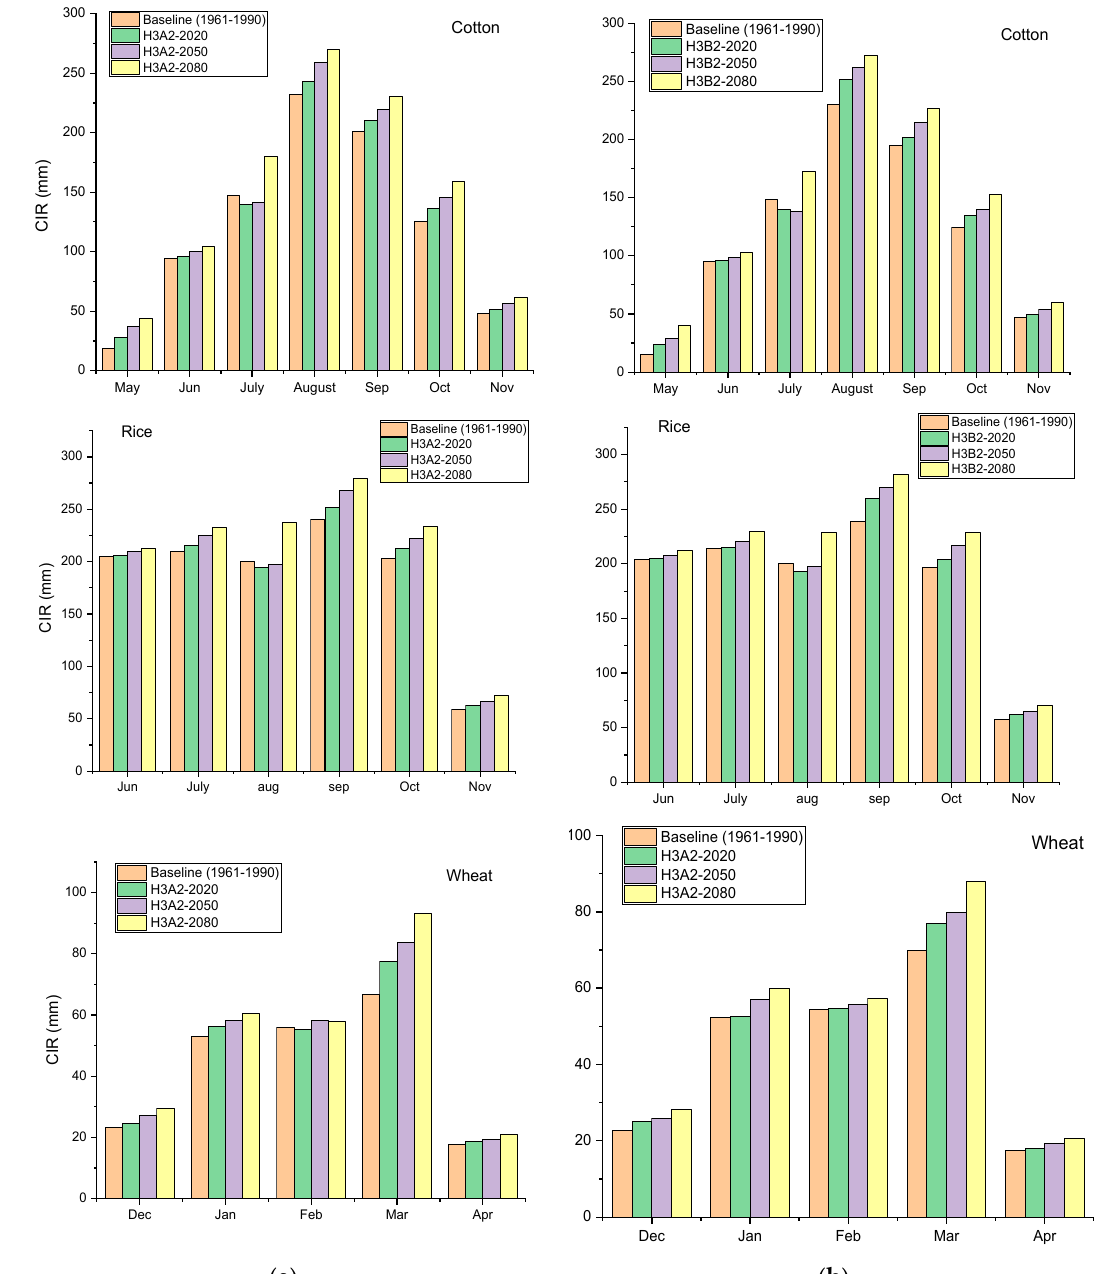
Figure 8. Monthly changes in crop irrigation requirement (CIR) of five agricultural crops, sugarcane, maize, cotton, rice, and wheat under ( a ) H3A2 and ( b ) H3B2 scenarios in Rechna Doab.